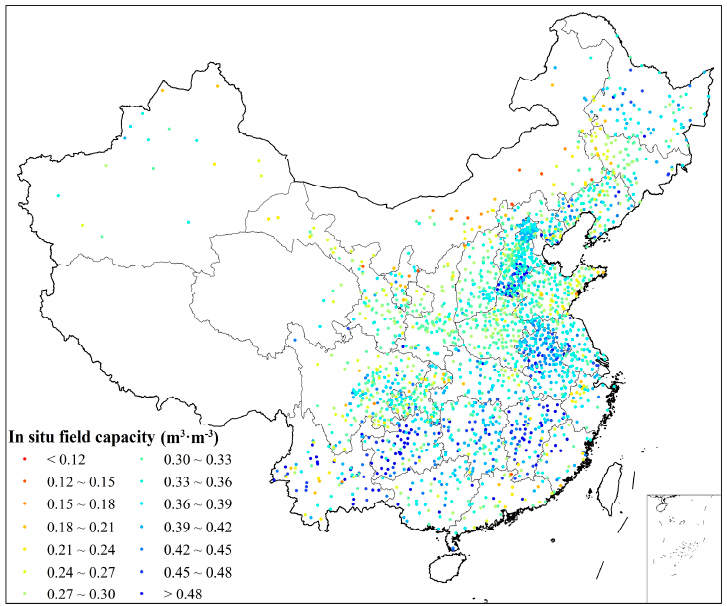
Figure 6. Distribution of in situ field capacity in China. Color bar is same as that in Figure 5.